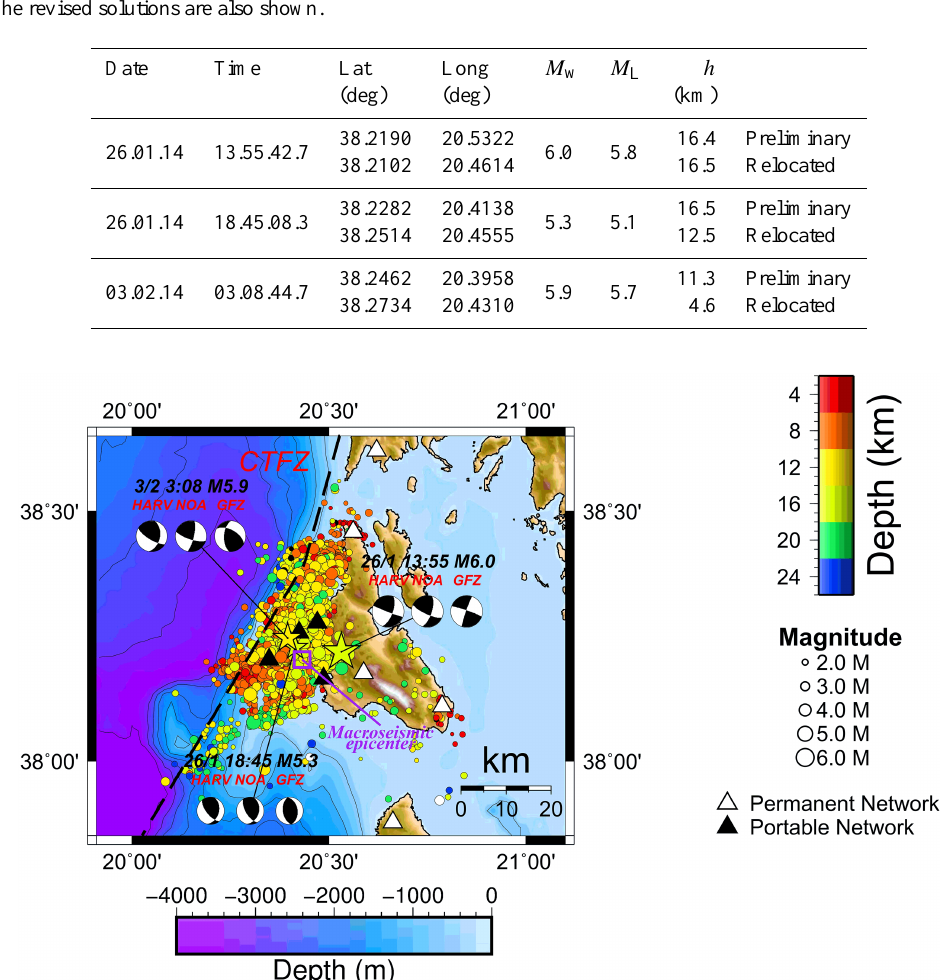
Figure 2. Map of the aftershock sequence from 26 January to 15 May 2014 as determined by the National Observatory of Athens. The moment tensor solutions for the largest events as calculated by the Global Centroid Moment Tensor Project: Harvard University, USA (HARV), National Observatory of Athens (NOA), and the German Research Centre for Geoscience